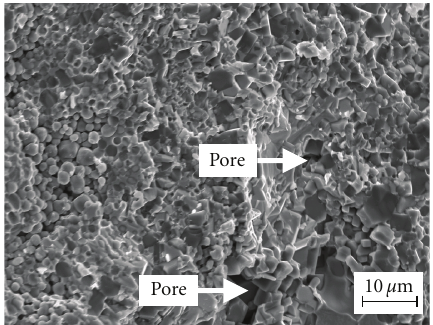
Figure 13: SEM photograph of fractured surface after three-point bending test of the specimen of TiC-TiB 2 -Ni(52.5/17.5/30) with